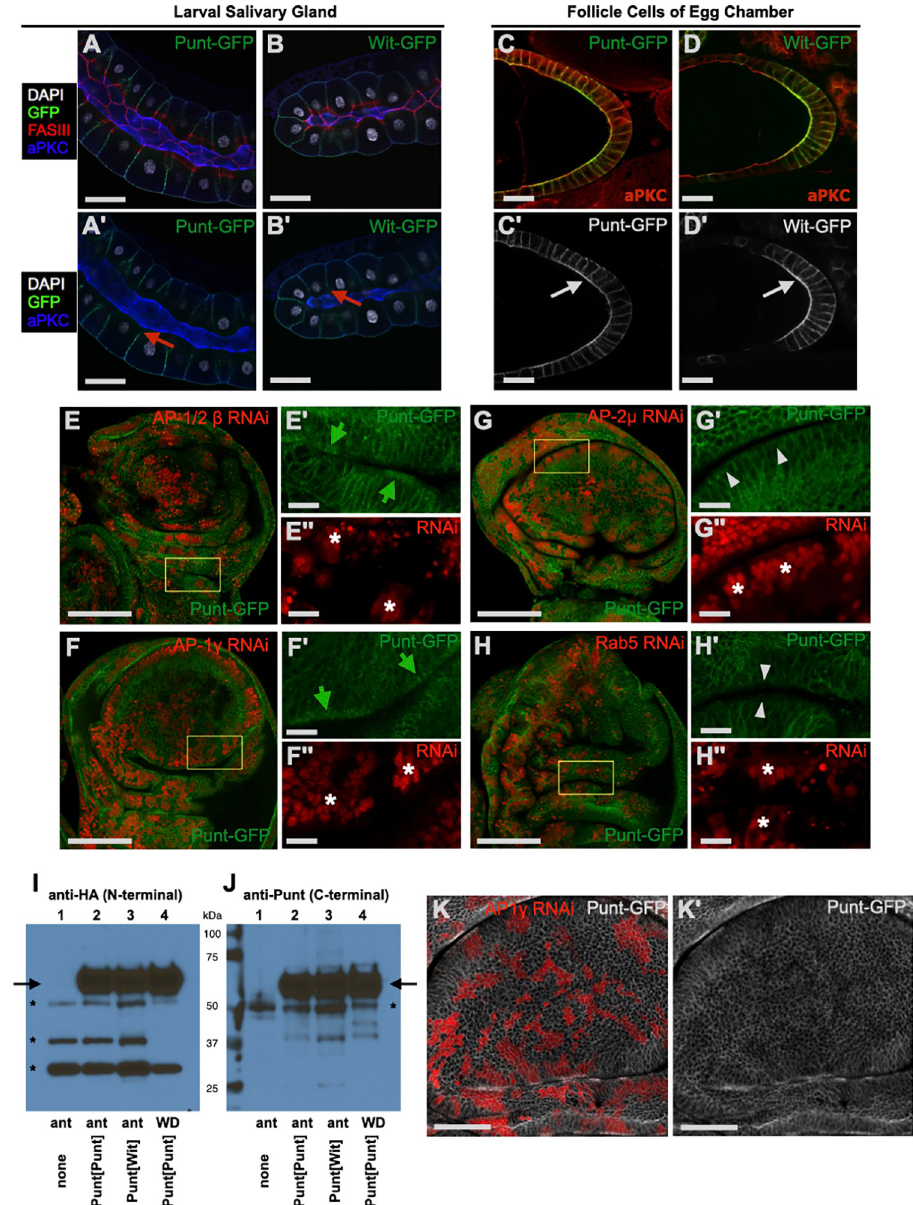
Fig 7. Membrane distribution of receptors varies by tissue and requires AP-1 sorting machinery in the wing disc. (A, B) Punt-GFP and Wit-GFP displayed basolateral restriction in the larval salivary gland epithelium. Confocal sections through the center of the salivary gland show cell polarity pointing exterior (basal) to interior (apical) with a central lumen (aPKC). Red arrows point to gap in GFP fluorescence signal at the SJ (A 0 , B 0 ). (C, D) Punt-GFP and Wit-GFP showed general membrane presentation in the follicle cell epithelium in the ovary. Arrows point to unambiguous GFP signal at the apical surface (C 0 , D 0 ). (E–H) Screening for apicalization of Punt-GFP in RNAi clones for trafficking factors. Clones are marked in red in whole disc confocal image and double-prime insets. GFP IF signal is shown in isolation in single-prime insets. Asterisks in the red channel point to example RNAi clones (E 00 –H 00 ). Green arrows point toward the apical surface and mark ectopic apical staining in RNAi clones relative to neighboring WT cells (E 0 , F 0 ). White arrowheads point toward the apical membrane for conditions where the apical level of Punt-GFP did not change between RNAi clones and control cells (G 0 , H 0 ). Punt-GFP is observed at the apical membrane near marked clones with RNAi knockdown of AP-1/2 β (E) or AP-1 γ (F). No such apical staining was observed in clones with RNAi knockdown for AP-2 components such as AP-2 μ (G) or for Rab5 (H). ( I–J) Western blot detection of Punt [Punt] and Punt[Wit]. Samples were collected from nub -GAL4 driving the indicated Punt construct. “ant” is anterior half of the larvae, including discs, and “WD” is specific dissection of Wing Discs. The HA epitope near the